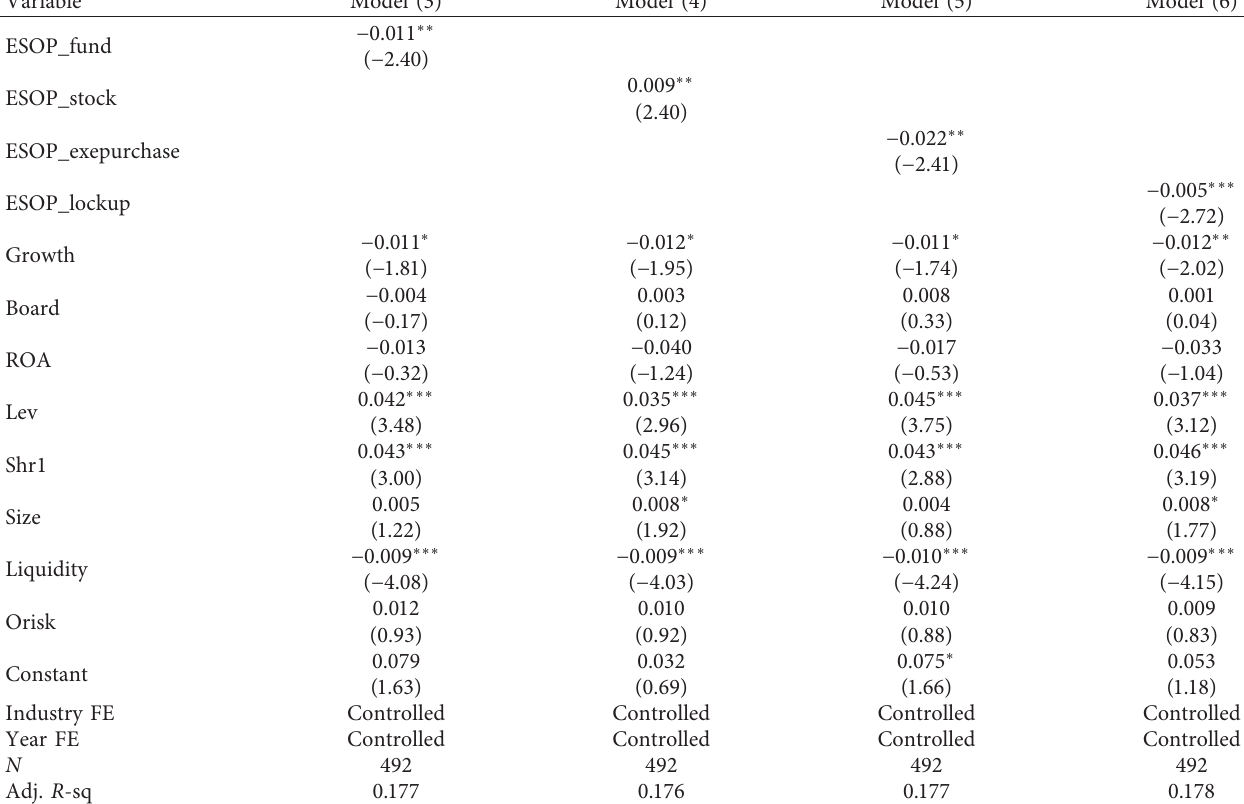
Table 5: Regression results: the impact of contract elements of ESOP on the cost of equity